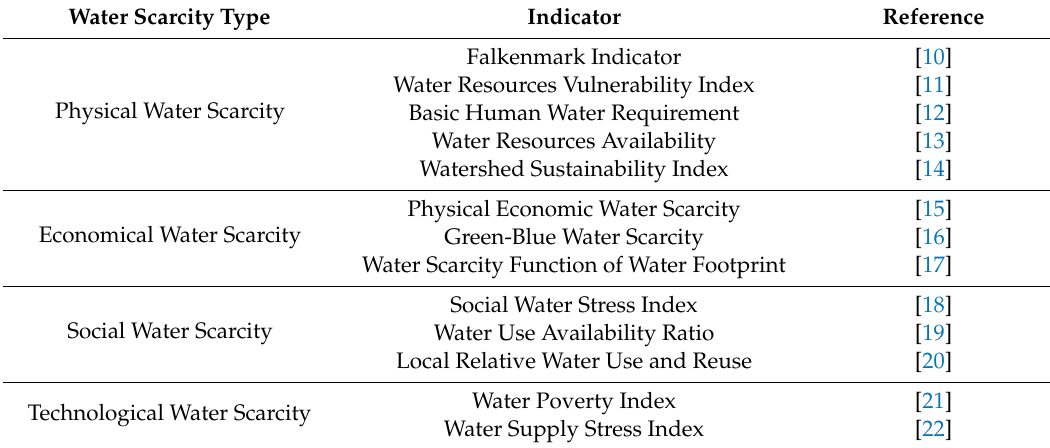
Table 2. Basic types of water scarcity and di ff erent introduced water stress